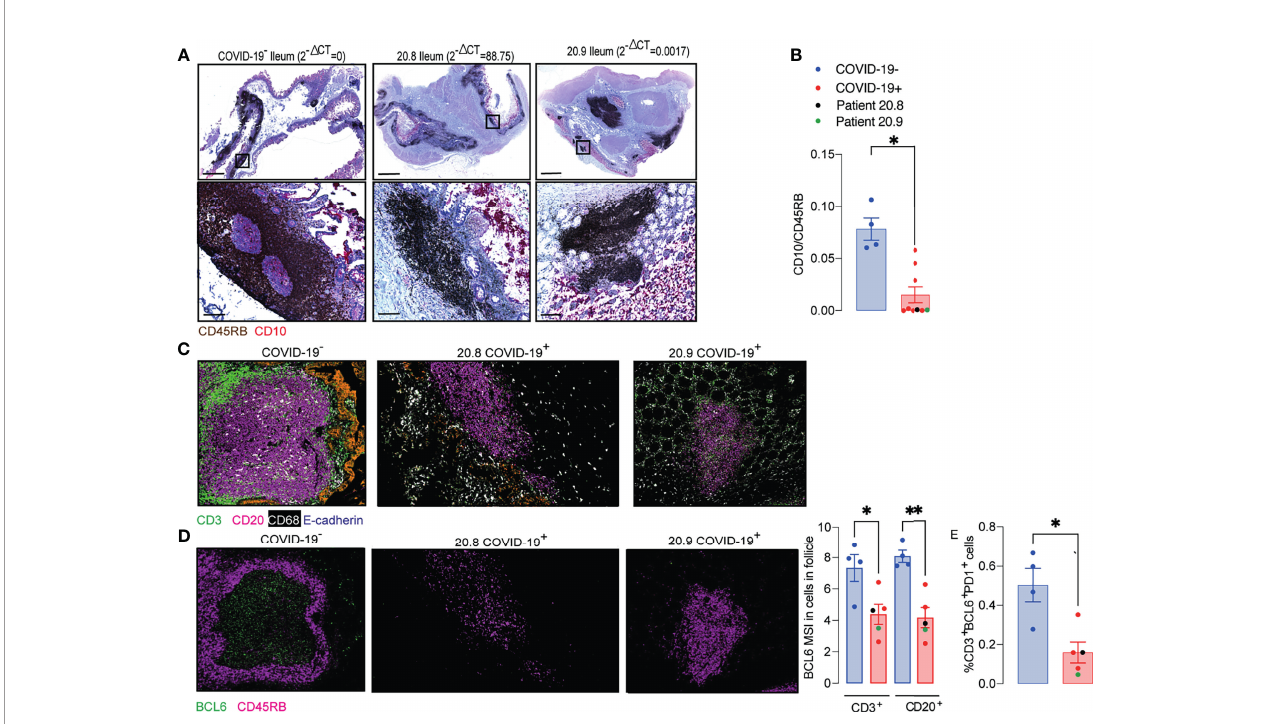
FIGURE 2 | Peyer ’ s patches (PP) from COVID-19 patients lose germinal centre. (A, B) IHC for CD45RB (brown) and CD10 (red) in ileal FFPE samples from COVID- 19 patients with different local levels of SARS-CoV-2 viral RNA. Images on the top show the whole sections and ileal follicles are highlighted in each of the bottom images. The images on the left represent a sample from one control; the images in the middle represent a sample from a COVID-19 patient with high local levels of viral RNA; and the images on the right represent a COVID-19 patient with low local levels of viral RNA. (B) CD10:CD45RB area ratio. Data is shown as mean ± SEM. (n = 4 controls and 9 patients). Two tailed Mann-Whitney t test. *P < 0.05. (C) Representative images from histoCAT showing CD3 (green), CD20 (magenta), E-cadherin (orange) and CD68 (white) signals in ileal samples. (D) Representative images from histoCAT showing CD45RB (magenta) and BCL6 (green) signals in PP follicle on the left, and mean BCL6 signals in T and B cells on the right. (E) Percentages of BCL6 + PD1 + cells T cells. Data is shown as mean ± SEM. (n = 4 controls and 5 patients). Kruskal-Wallis followed Dunn ’ s post-test. *P < 0.05, **P <